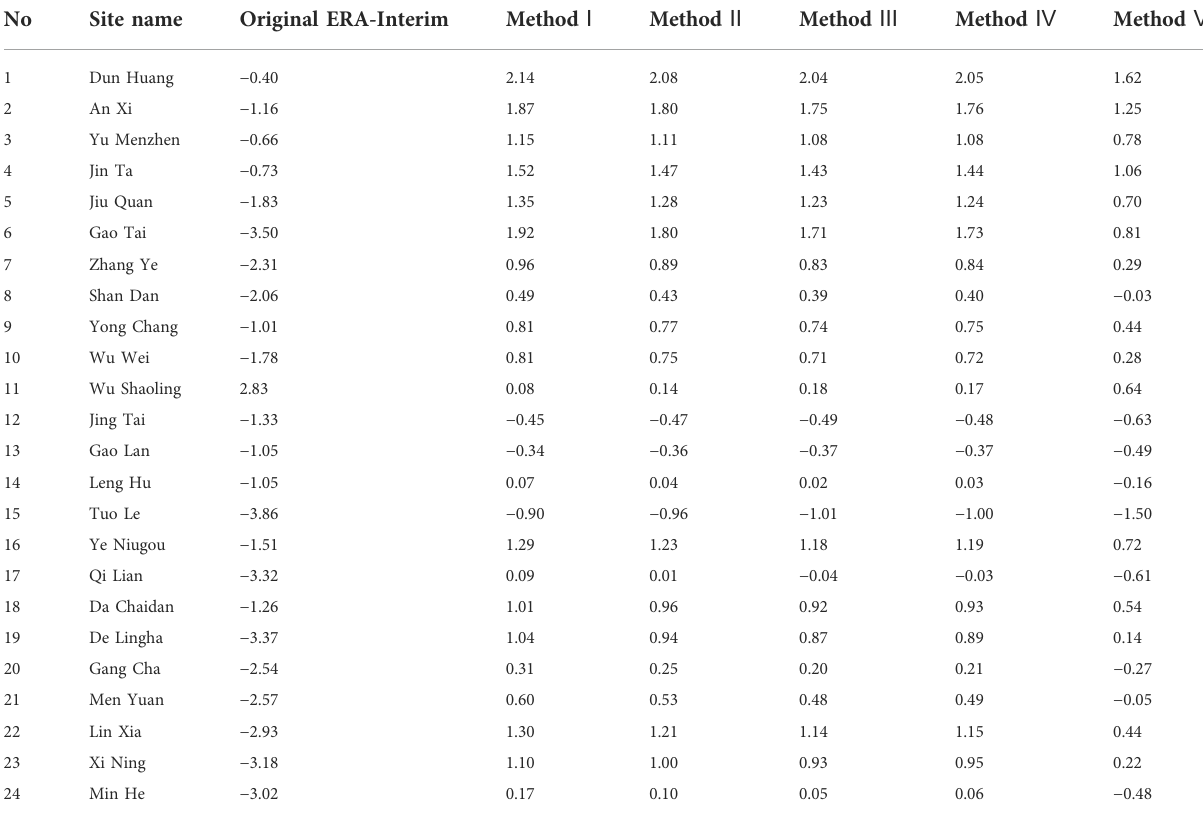
TABLE 4 Biases ( ° C) between daily observed and original ERA-Interim temperature, and between observed and corrected ERA-Interim temperature (Methods I ‒ V) for 24 meteorological stations during the period 1979 –